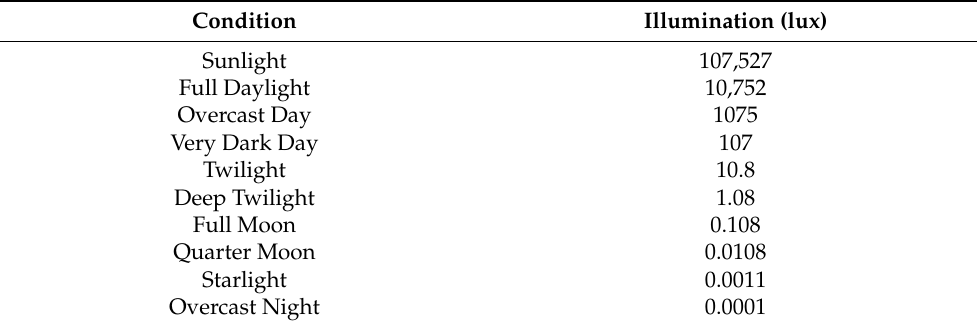
Table 1. Measured results for light amount in plane